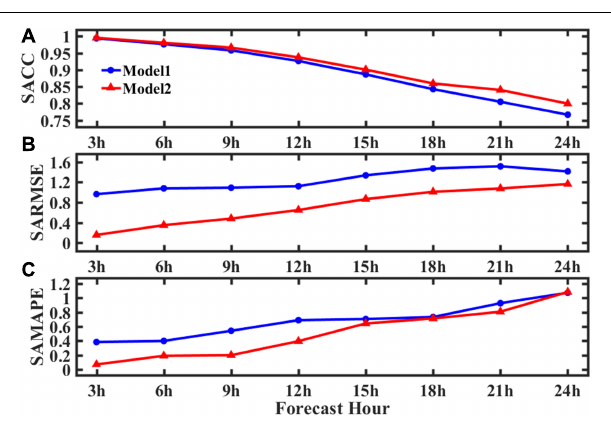
FIGURE 6 | Error statistics of Models 1 and 2 relative to the WW3 baseline. (A) SACC, (B) SARMSE, and (C)